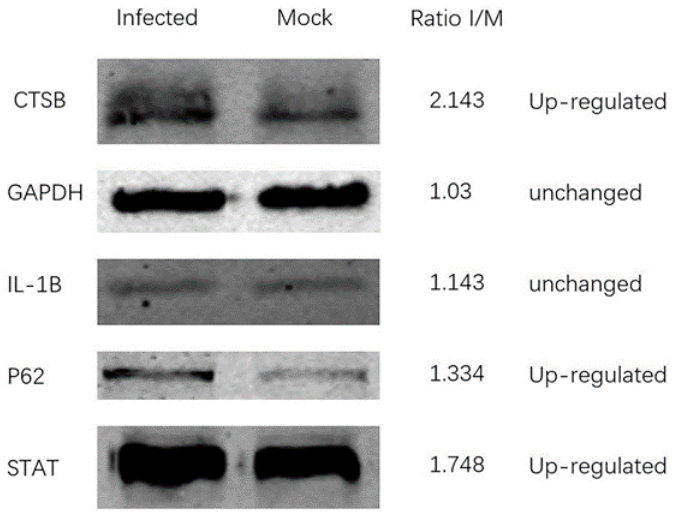
Figure 3. Western blot analysis of host proteins in mock-infected and ASFV-infected PAM cells at 24 h p.i. The TMT ratios (ratio I/M) obtained by mass spectrometry analysis are displayed on the right side.